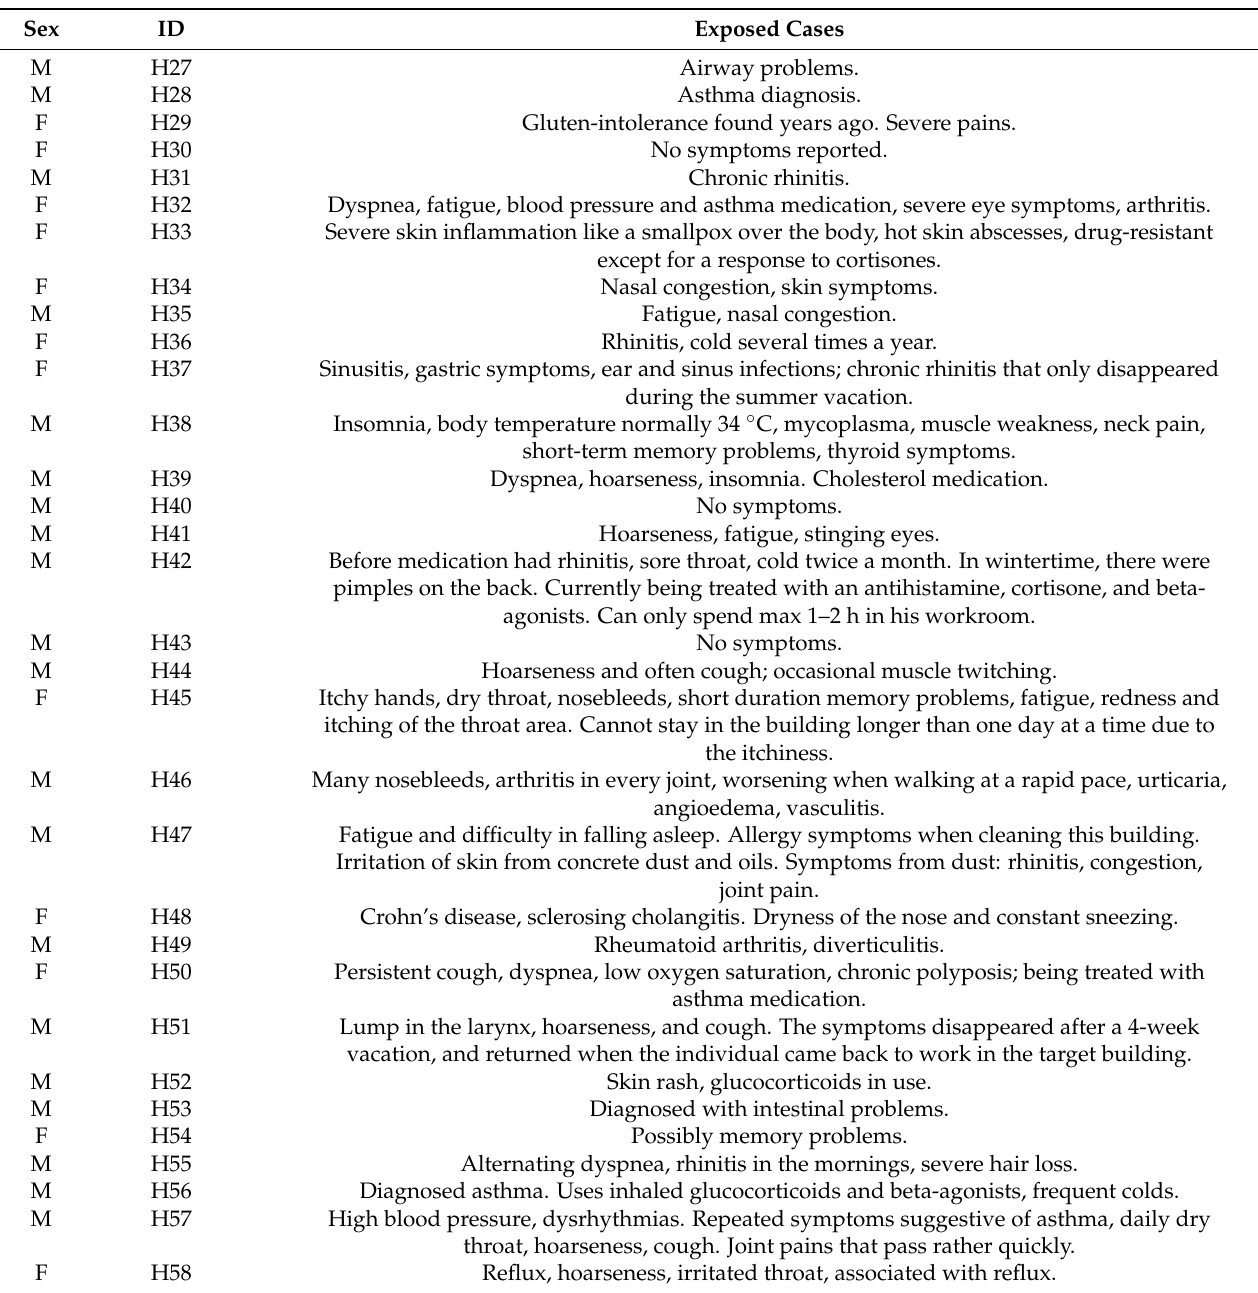
Table 2. Self-reported symptoms reported from employees in the target (29/32 subjects, 91%) and control buildings (4/18 subjects,